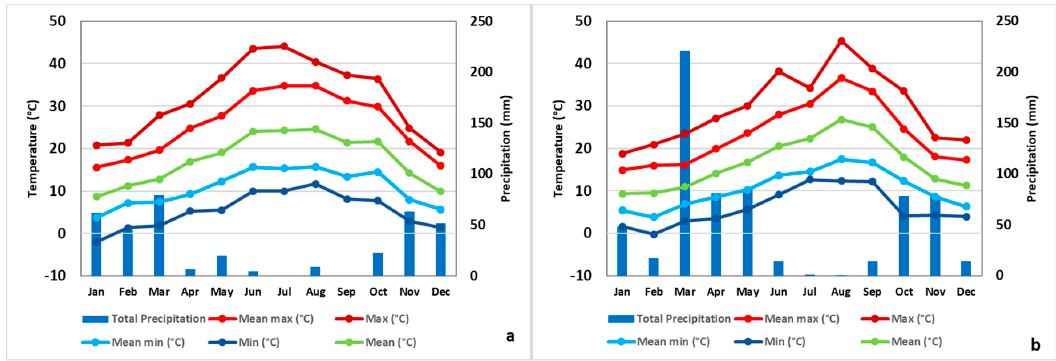
Figure 4. Meteorological conditions at case study I—Lezíria do Tejo region for ( a ) 2017 and ( b ) 2018.